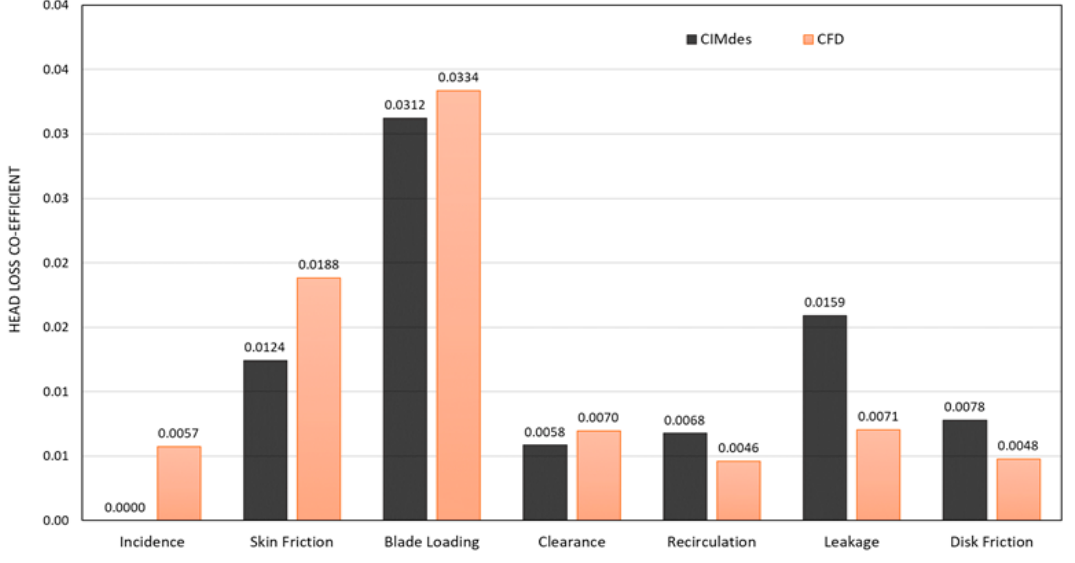
Figure 23. Loss comparison of 1D and 3D steady RANS solution for single-stage radial impeller.